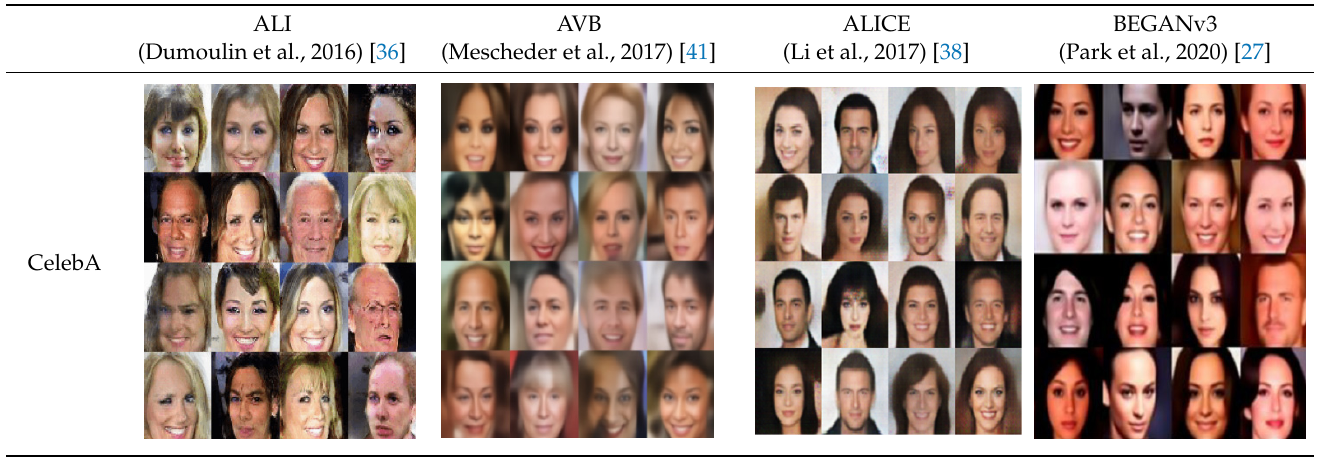
Table 4. Visual results of different models trained with the CelebA dataset. More results are presented in that paper.